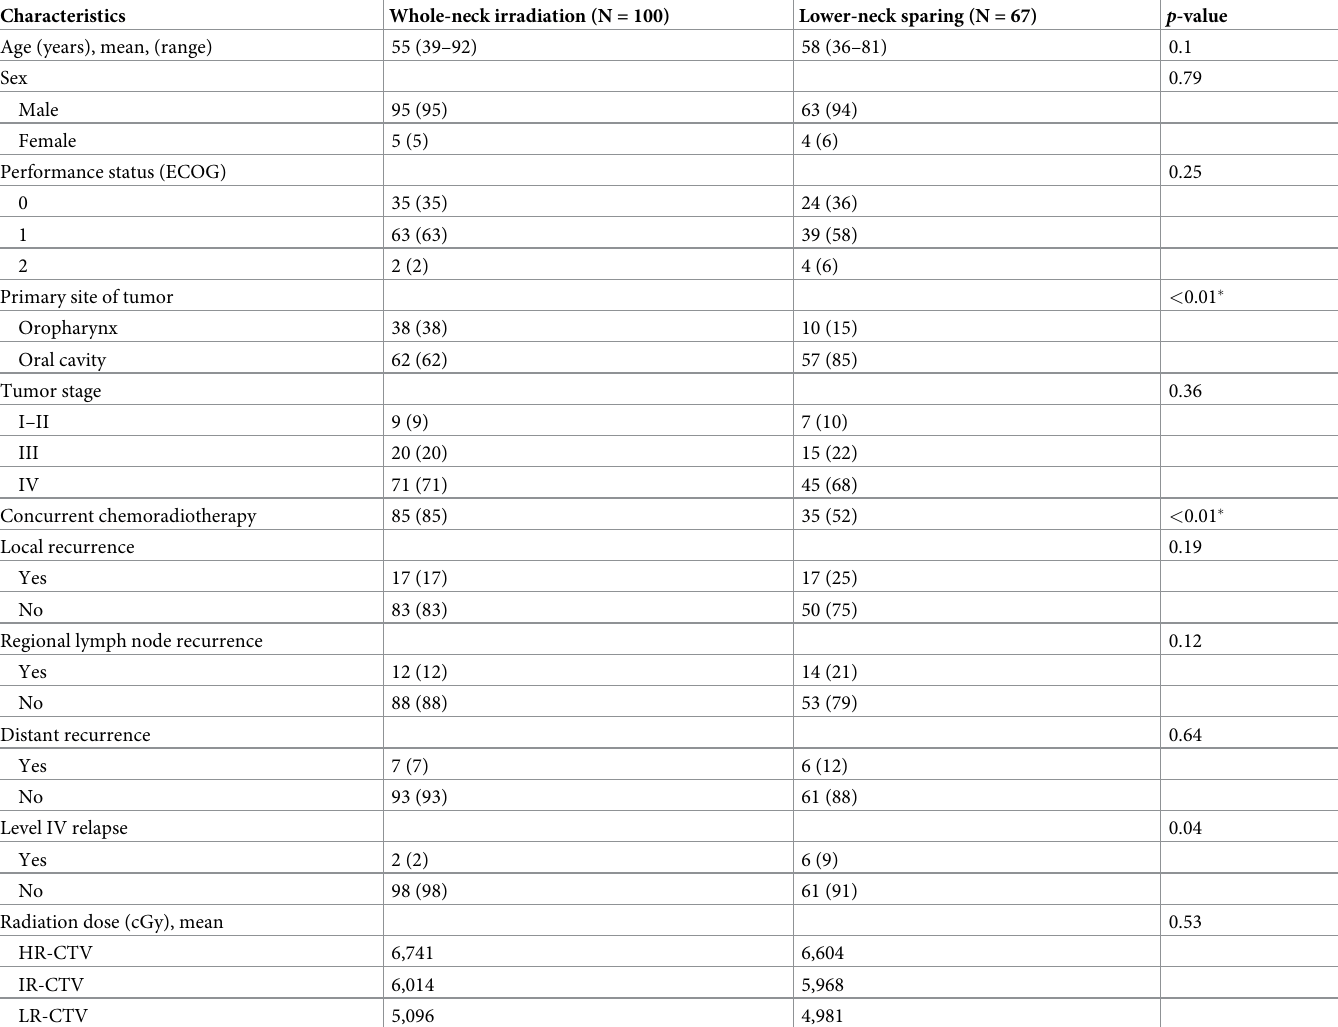
Table 2. Comparison of patients treated with WNI and